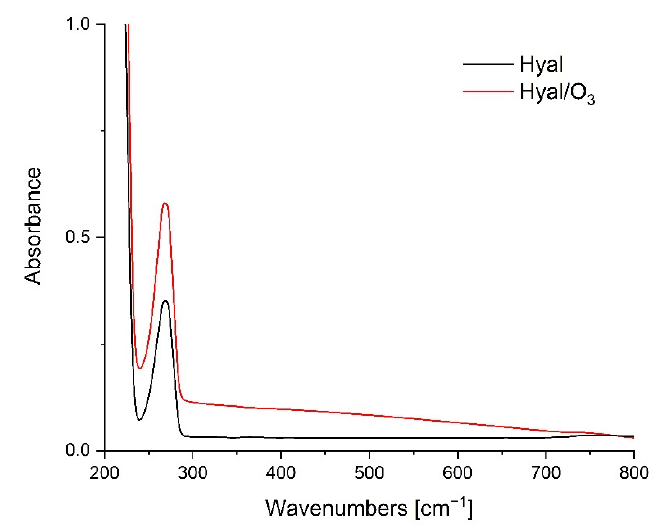
Figure 2. UV-Vis spectra for Hyal and Hyal/O 3 films. Figure 2. UV ‐ Vis spectra for Hyal and Hyal/O 3 films.